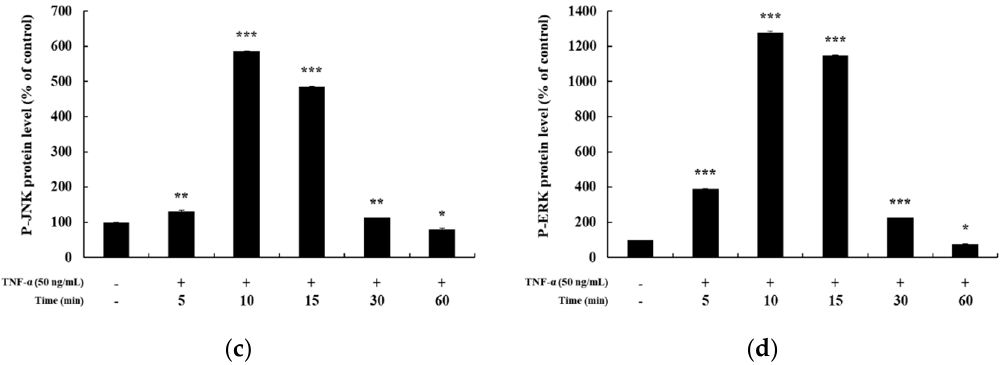
Figure 3. Effect of TNF- α on mitogen-activated protein kinase MAPK pathway in HaCaT cells. Cells were treated with TNF- α (50 ng/mL) for 5, 10, 15, 30, and 60 min, and cell lysates were prepared for western blot analysis. Data are presented as the mean ± SD (n = 3). * p < 0.05, ** p < 0.01, and *** p < 0.001 vs. control.